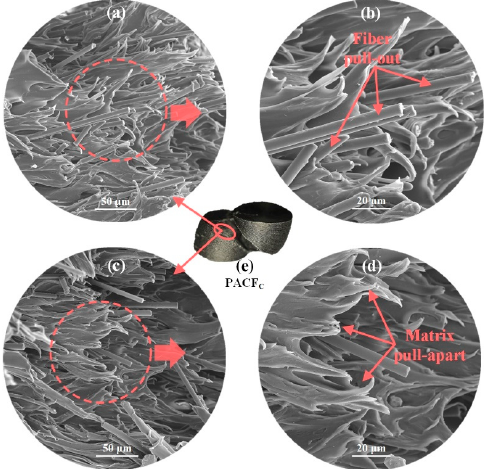
Figure 10. Assessment of printed columns based on indicators of crushing properties: ( a ) PA; ( b ) PAGF; ( c ) PACF (printed in three directions and printed at 240 °C).